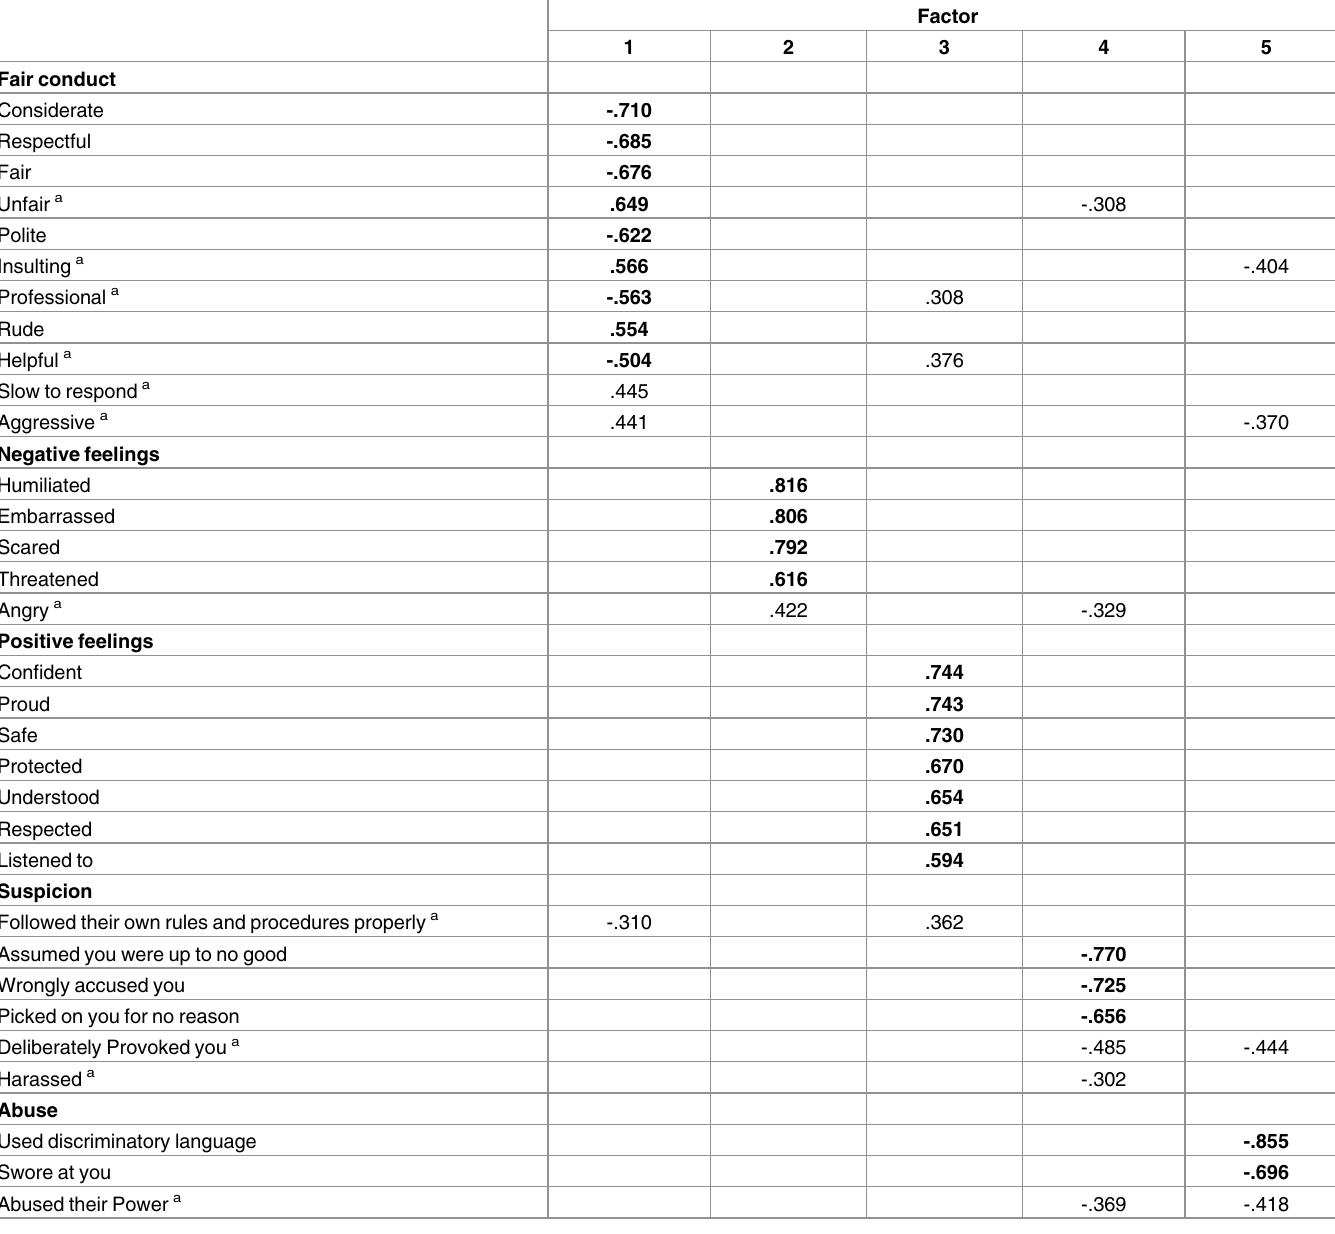
Table 2. Rotated (Oblimin) factor loadings of experienceitems on five factors extracted with principal axis